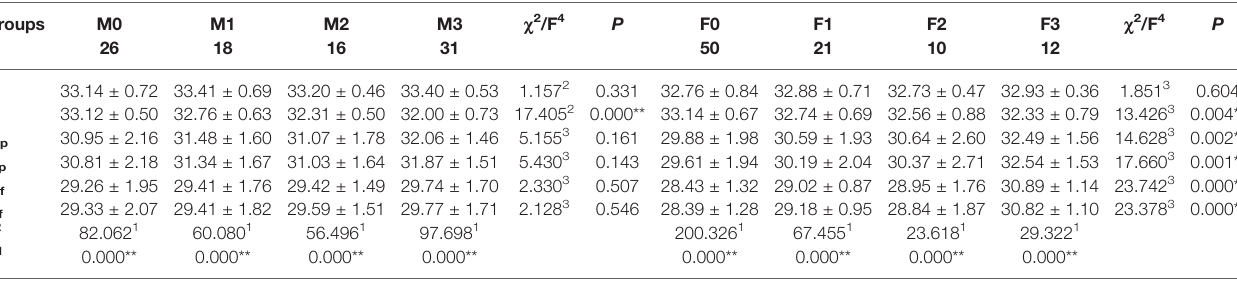
TABLE 2 | Comparison of T mean of each ROI among four groups in each gender (C; (cid:1) x ± s). Groups